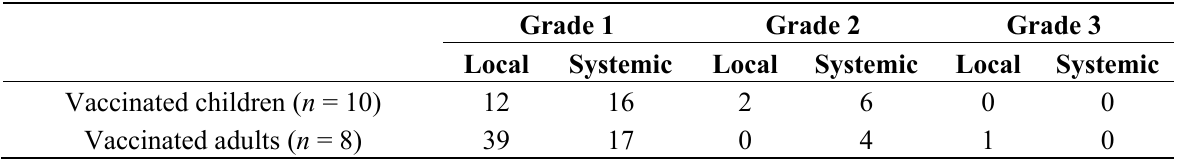
Table 2. Reported adverse events of